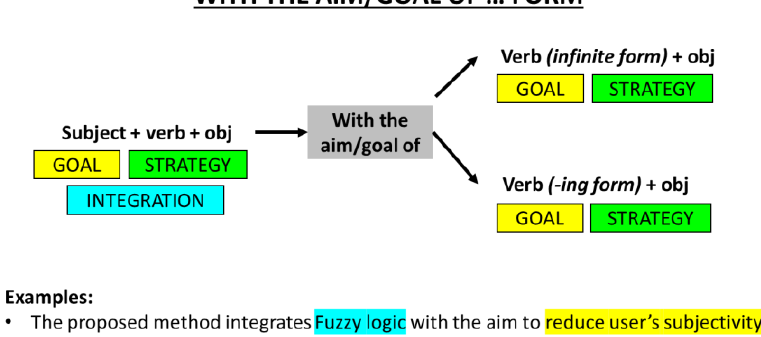
Figure 2. Common uses of the constructs "With the aim of …" and "With the goal of …".